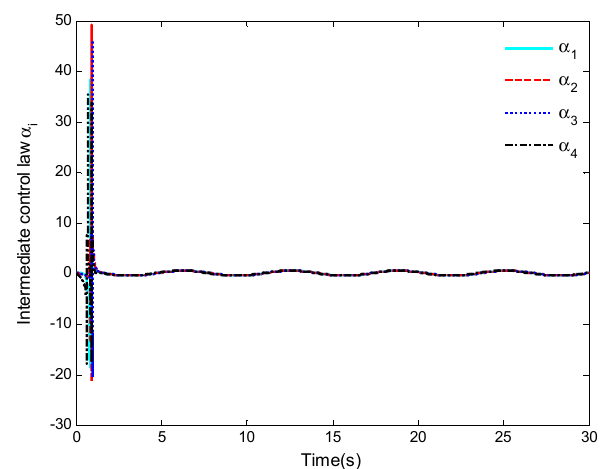
Figure 13. The curves of the intermediate control law α i .